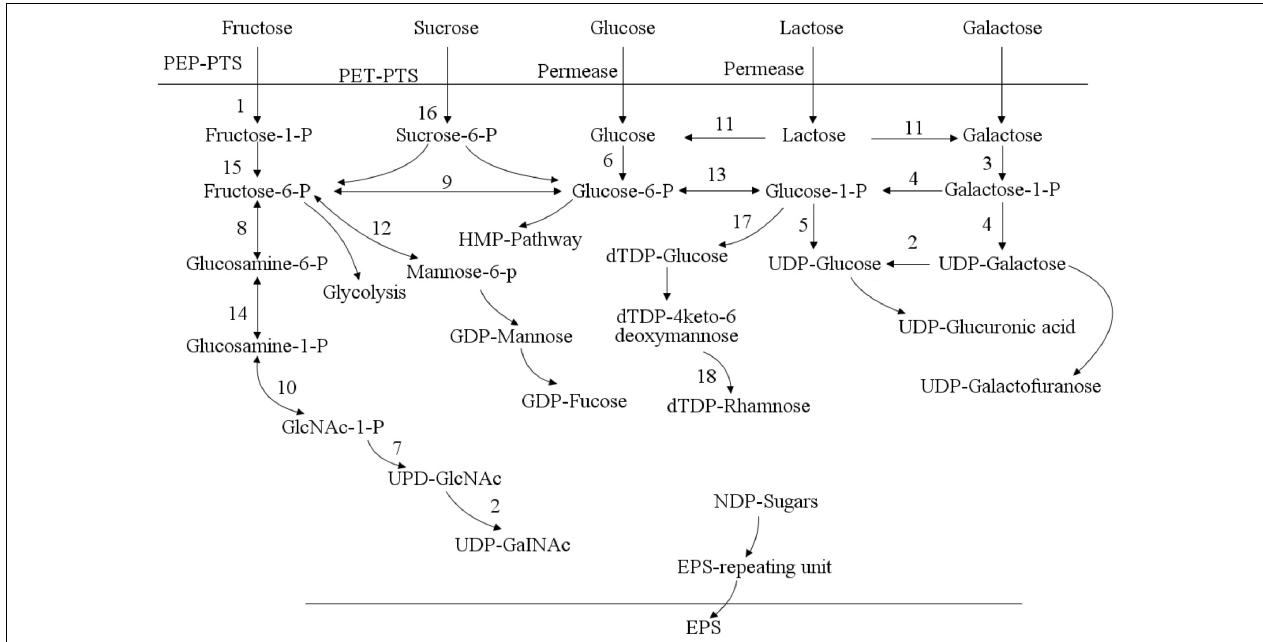
FIGURE 3 | Pathways of sugar metabolism and exopolysaccharides (EPS) biosynthesis in Streptococcus thermophilus (Laws et al., 2001). In Streptococcus thermophilus , exopolysaccharides is synthesized through a series of complex intracellular enzyme interactions. It is exported to the extracellular environment in the form of macromolecules through a special lipid carrier. The biosynthetic pathway of exopolysaccharides includes sugar entry into the cytoplasm, sugar-1-phosphate synthesis, polysaccharide synthesis and exopolysaccharides export. 1: fructokinase; 2: UDP-galactose-4-epimerase; 3: galactokinase; 4: galactose-1-phosphate uridylyltransferase; 5: UDP-glucose pyrophosphorylase; 6: glucokinase; 7: N-acetylglucosamine-1-phosphate uridyltransferase; 8: glucosamine-6-phosphate deaminase; 9: glucose-6-phosphate isomerase; 10: glucosamine-1-phosphate N-acetyltransferase; 11: β -glalactosidase; 12: mannose-6 phosphate isomerase; 13: α -phosphoglucomutase; 14: phosphoglucosamine mutase; 15: phosphomutase; 16: sucrose-6-phosphate hydrolase; 17: dTDP-glucose pyrophosphorylase; 18: UDP-glucose 6-dehydrogenase.